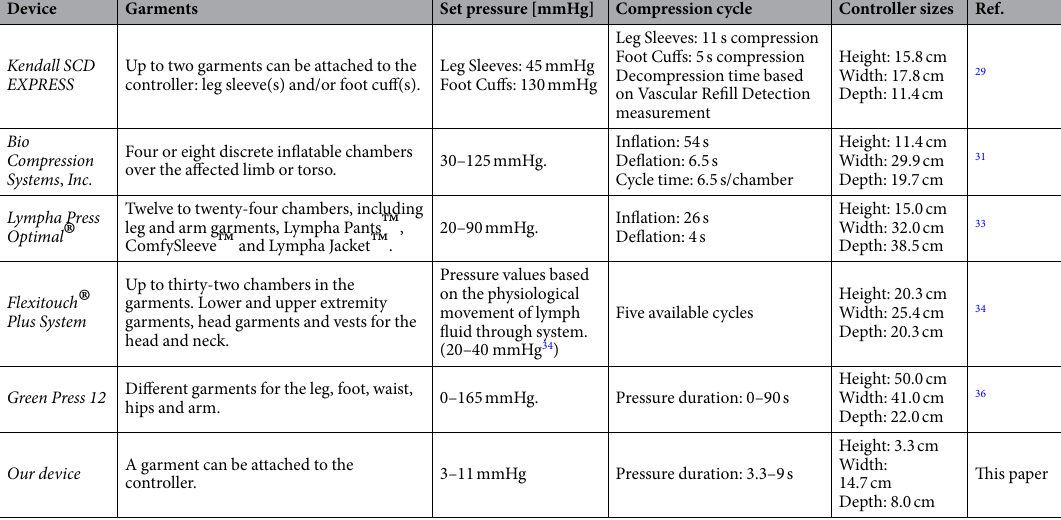
Table 3. Comparison of the properties of commercial IPC devices to the device proposed in this